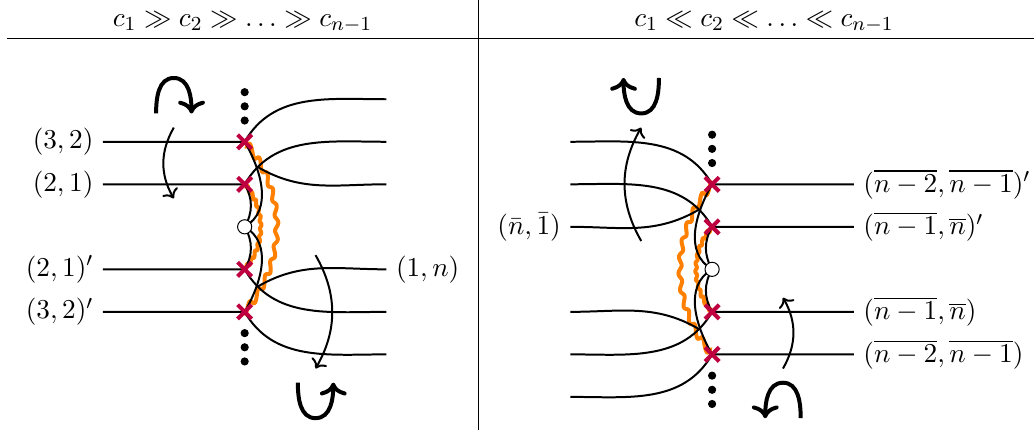
Figure 12 . Spectral curve for two punctures in su n , (cid:3)